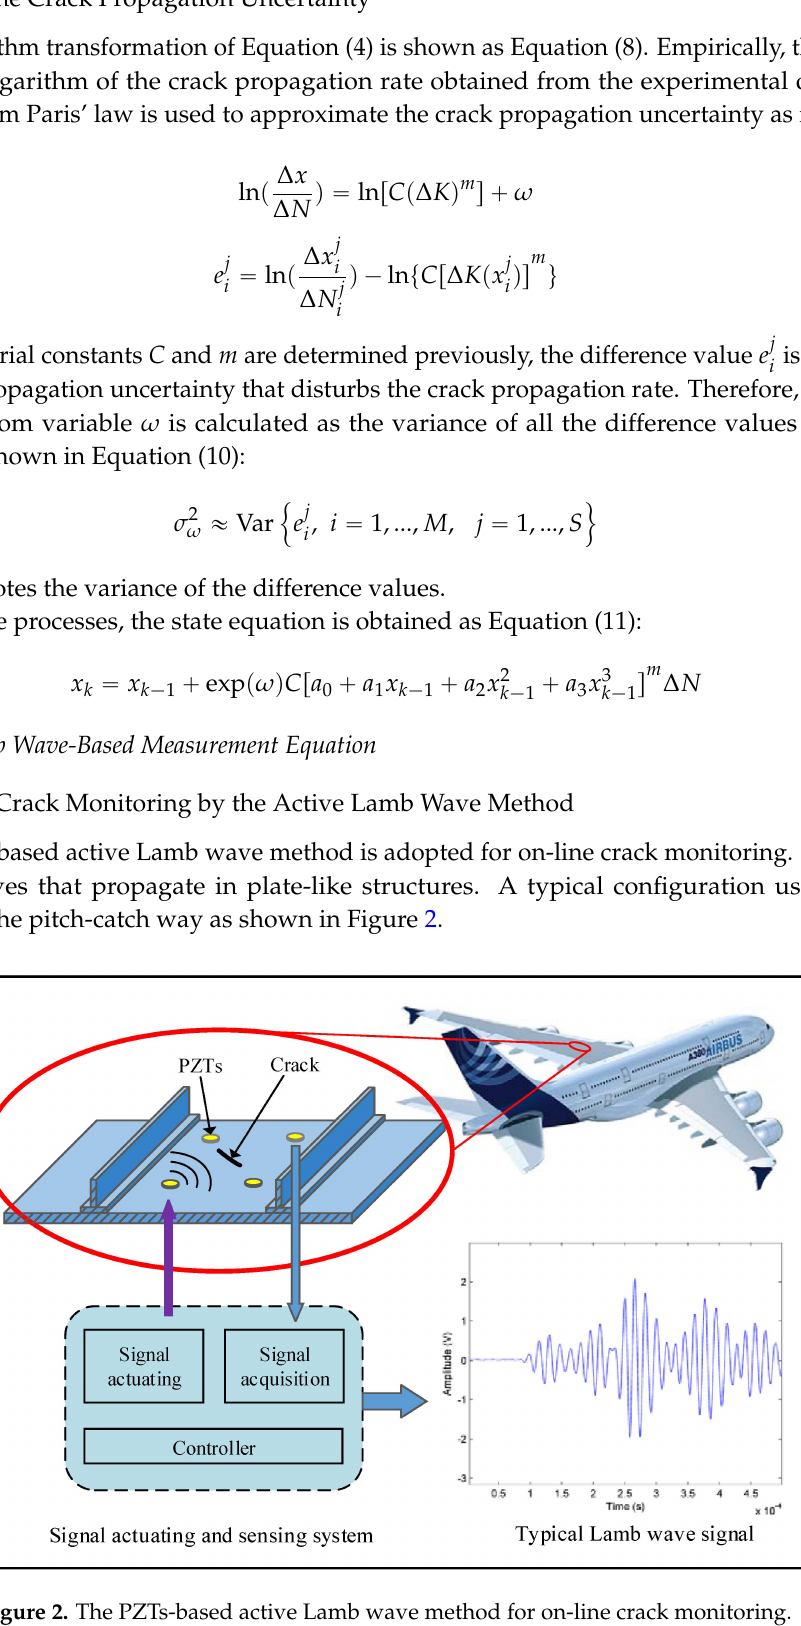
Figure 2. The PZTs-based active Lamb wave method for on-line crack